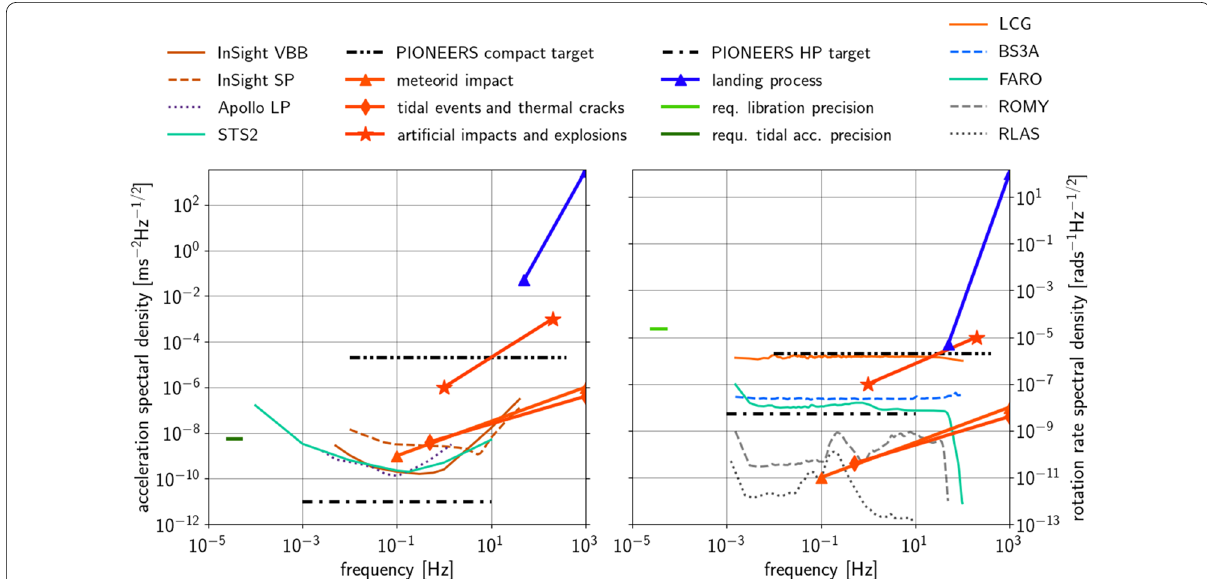
Fig. 6 Expected signal levels on Phobos. For forced librations and tidal accelerations, the required resolution is shown. Additionally, self‑noise levels of commonly used sensors are shown (see Fig.